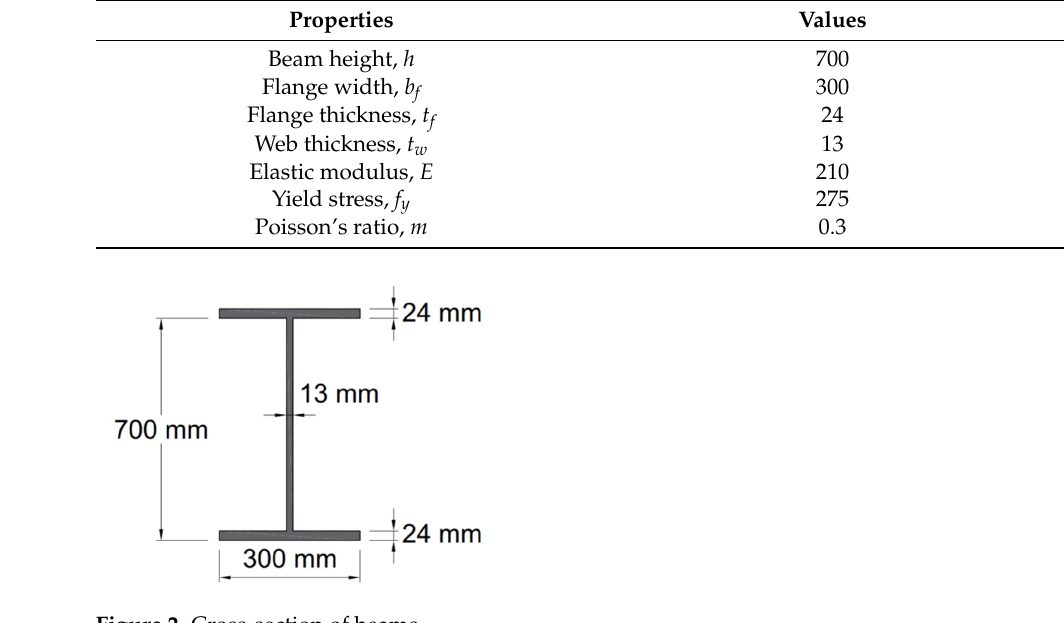
Figure 2. Cross-section of beams.